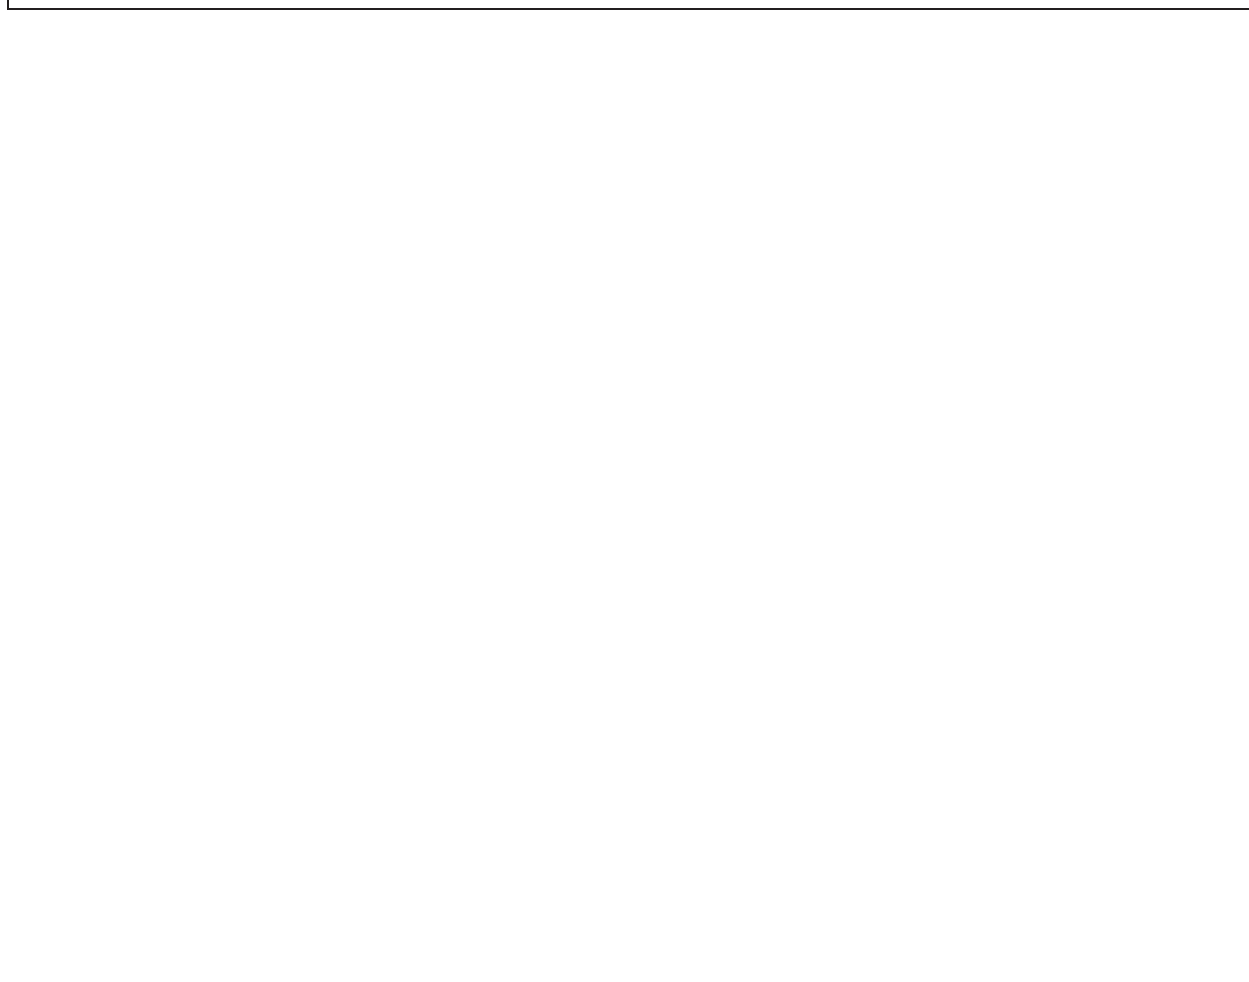
FIGURE A1 | fMRI contrast of the main effect of valence on viewing emotional images. BOLD response was greater during negative, as compared to neutral emotional images in left Amygdala [ x = − 24, y = − 4, z = − 14] and right Insula [ x = 38, y = − 16, z = 14] p < 0 . 05 (cluster